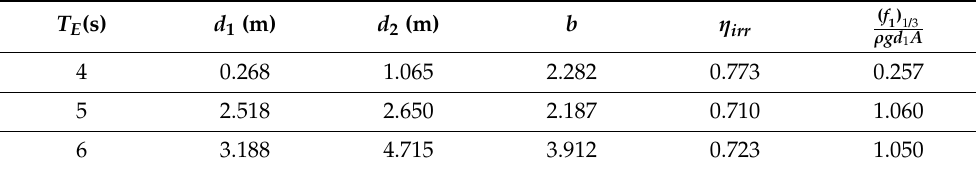
Figure 18. Optimal geometric values of barrier height ( a ), submergence depth of a chamber wall ( b ), and barrier distance ( c ) of a U-OWC at T E = 5 s in irregular waves. Table 3. Optimal geometric values of the U-OWC for different energy periods.